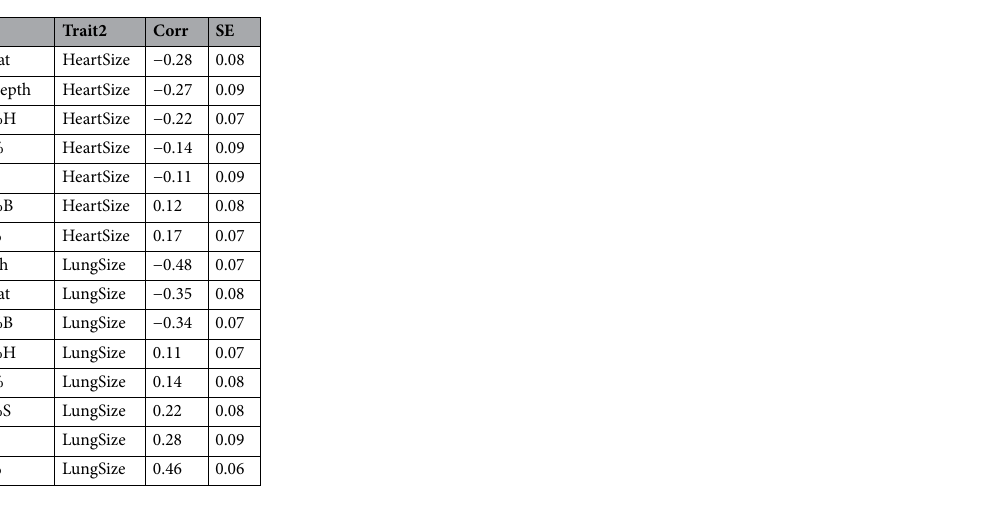
Table 3. Genetic correlation between heart and lung volumes and other relevant traits for Landrace. BackFat backfat at 100 kg’s, LoinDepth loindepth at 100 kg’s, Prim%H primal % for ham, Yield% yield % for carcass (incl. head), Age40 age at 40 kg’s, Prim%B primal % for belly, Lean% lean meat % (incl. head), Growth average daily gain from 40 to 120 kg’s, Prim%S primal % for